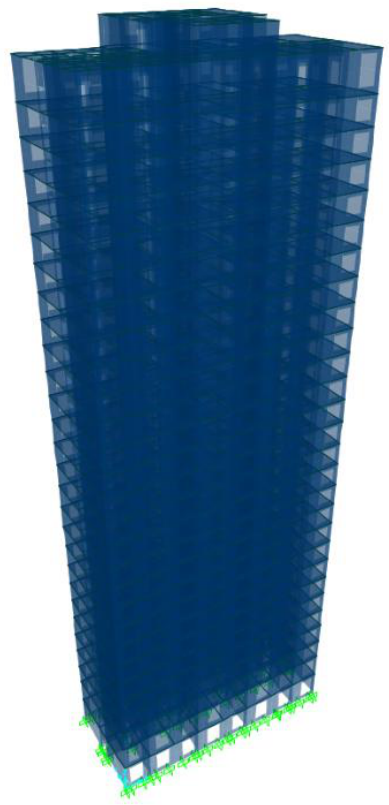
Figure 8. Finite element modeling for the high-rise reinforced masonry structure.